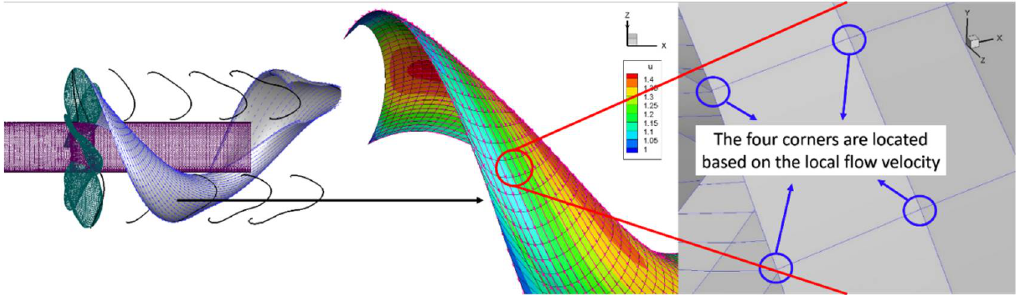
Figure 2. Key wake with the local velocity vectors (red arrows in the middle figure) plotted on each nodal point of the wake, taken from Kim